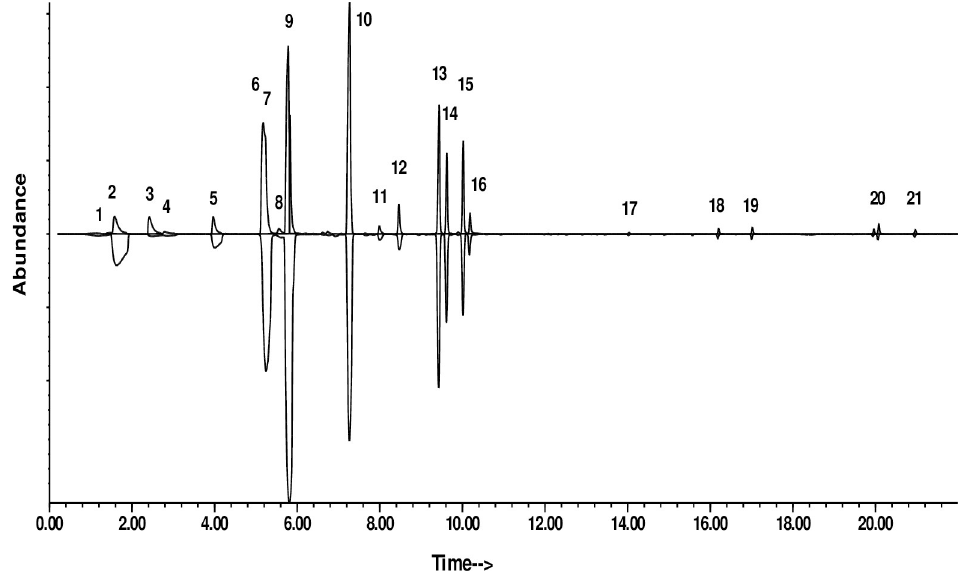
Fig 1. Top trace: Total ion chromatogram of reconstructed odor blend of the papaya-flavored oil in canola oil carrier; Inverted bottom trace: Total ion chromatogram of papaya-flavored oil as received from the supplier. Peak numbers correspond to the compounds listed in Table